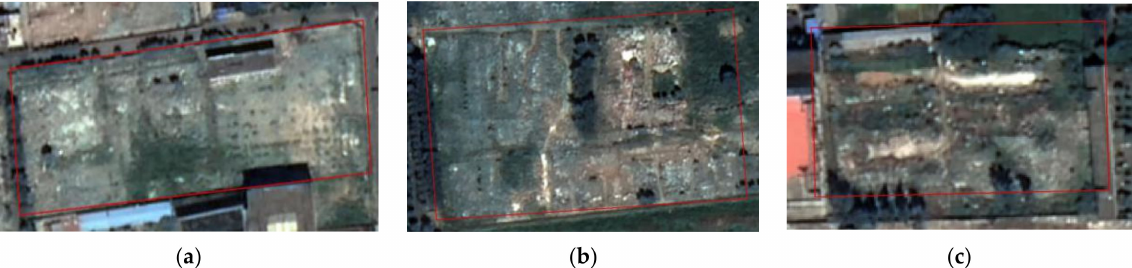
Figure 30. Construction waste covered with vegetation: ( a , b ) the spectral features of the construction waste, ( c ) the presence of vegetation in the image object and the use of red bands used to separate vegetation and road at both levels of the classification